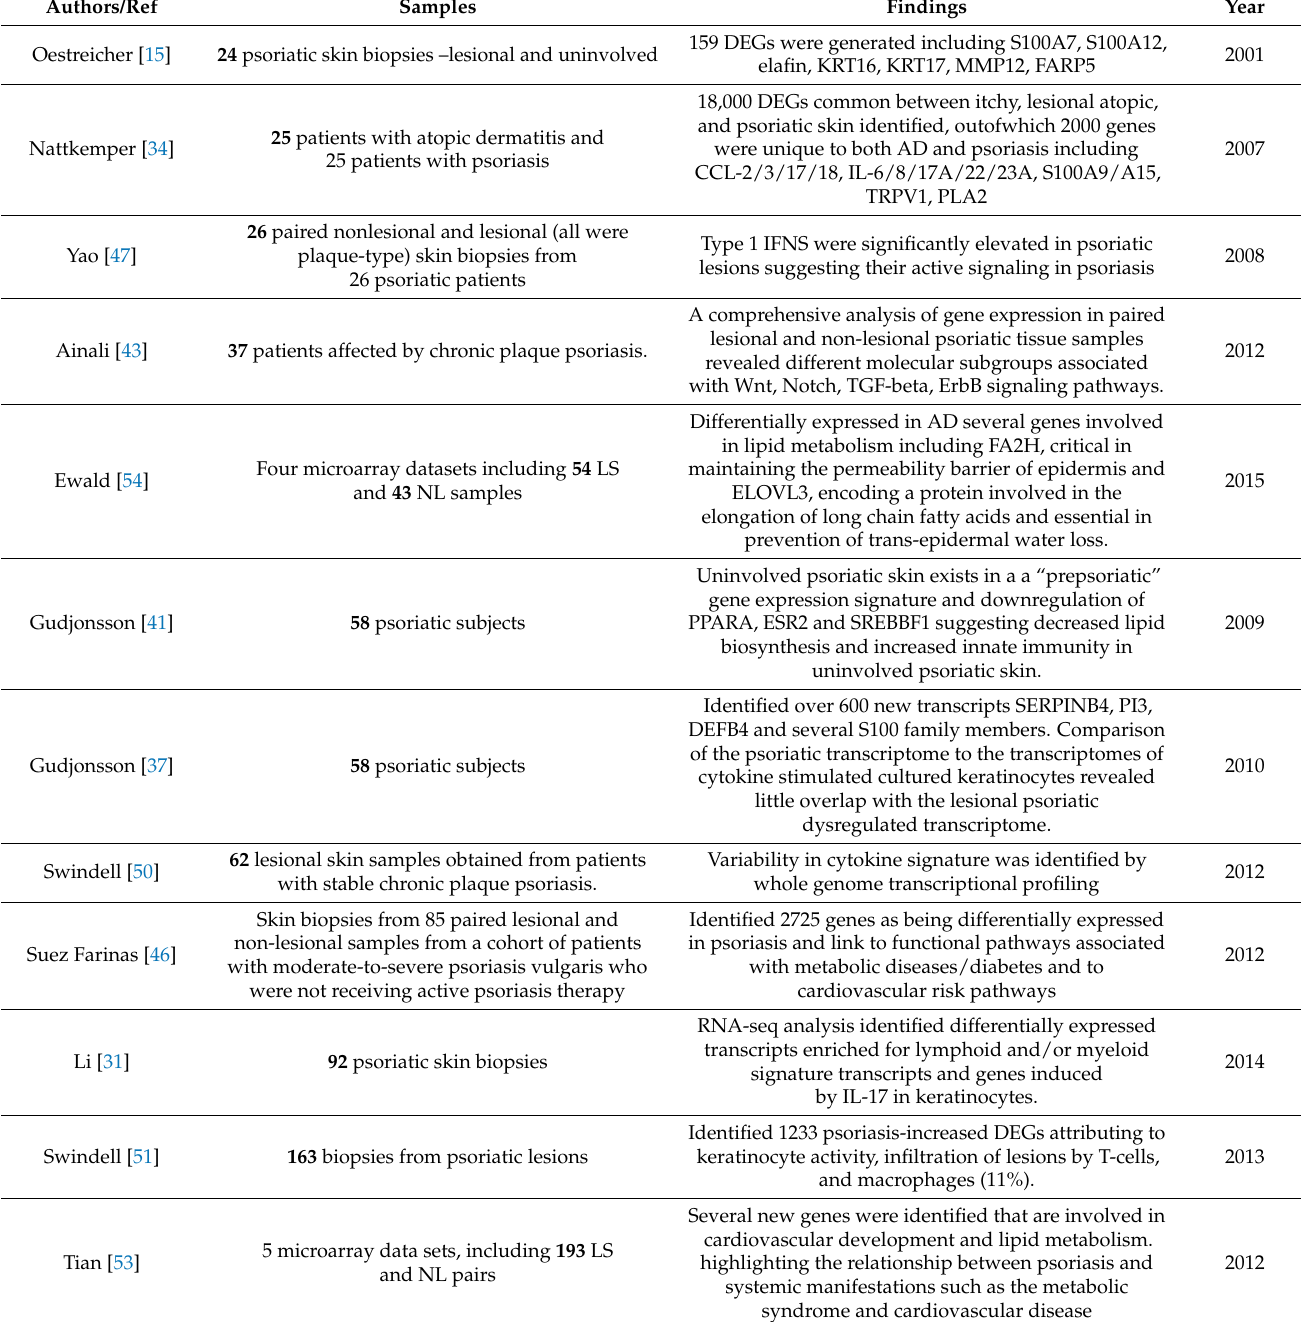
Table 1. Large scale (>20 samples) psoriasis transcriptomic